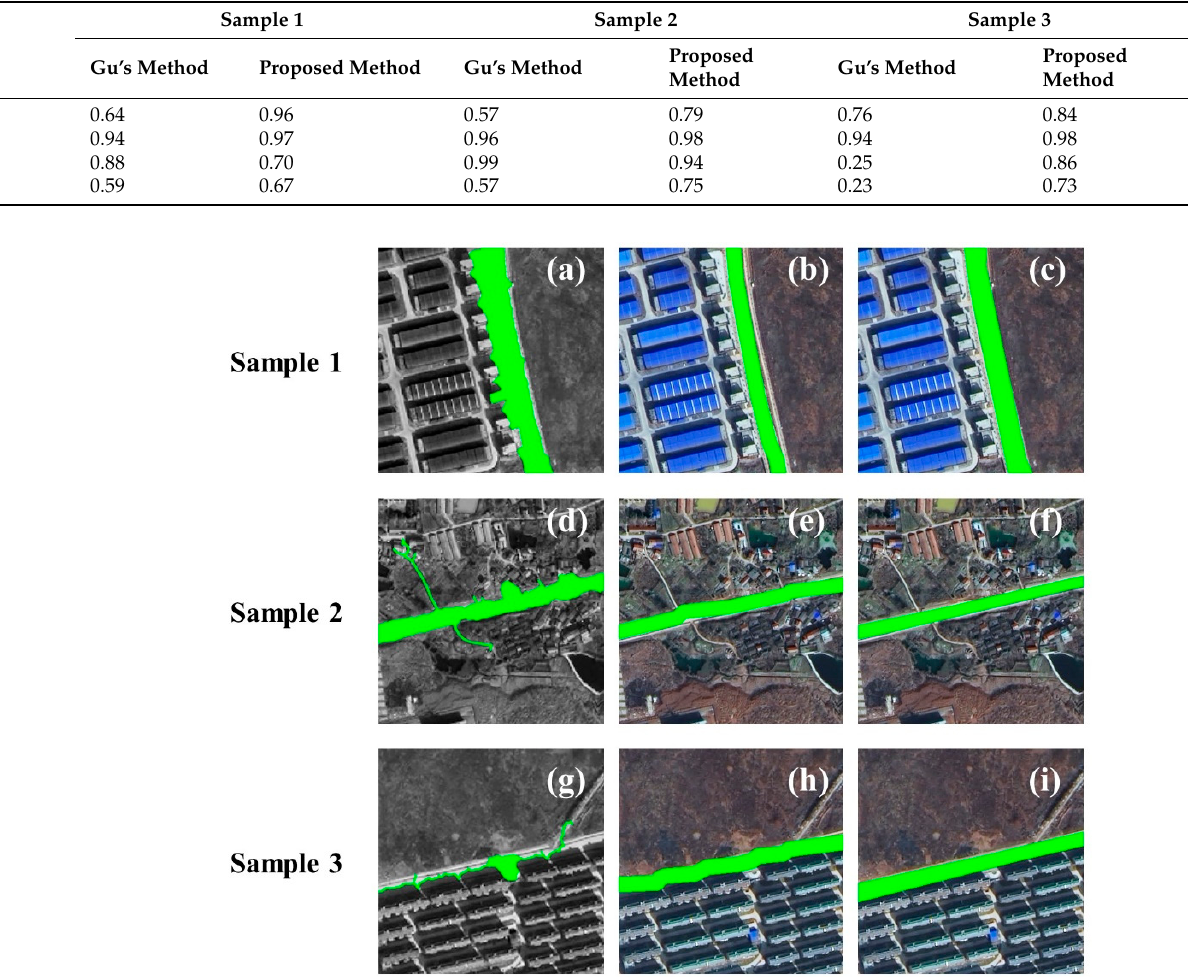
Figure 17. Comparison with Gu’s method: ( a , d , g ) are the results of Gu’s method; ( b , e , h ) are the results of the proposed method; ( c , f , i ) are the ground truth. Table 3. Performance of local road extraction by Gu’s method and the proposed method.